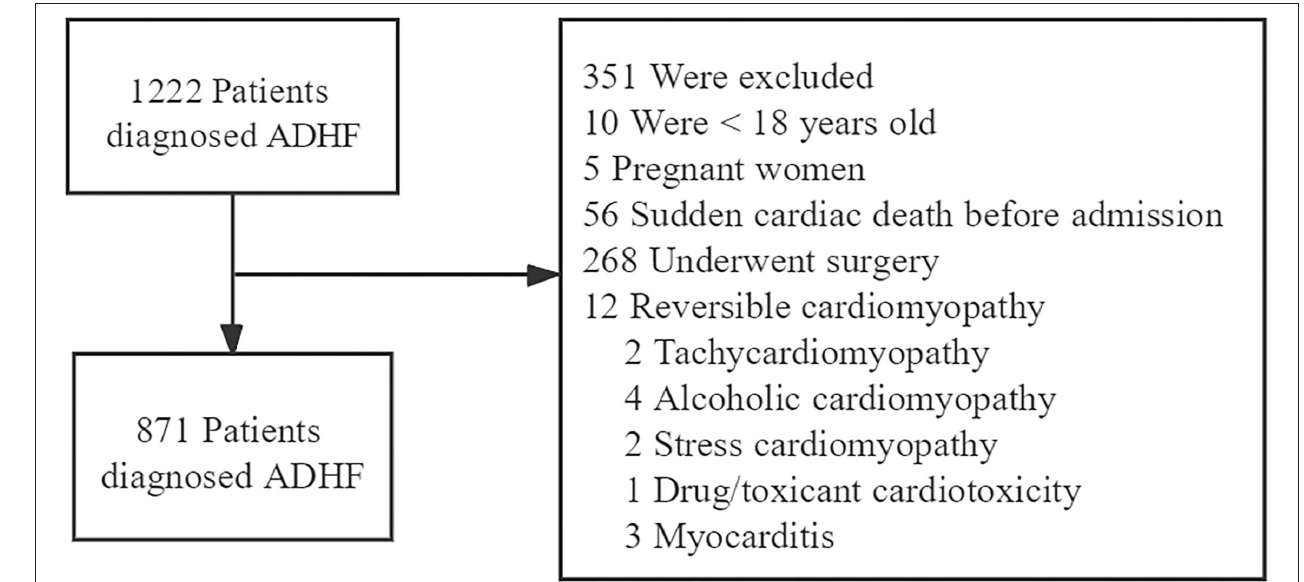
FIGURE 1 | Flow chart demonstrating the process of selection from a total of 1,222 patients.